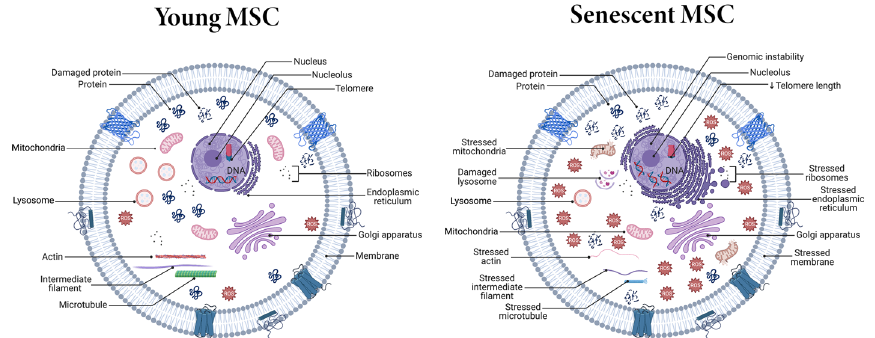
Fig. 5 Concept of young MSCs versus senescent MSCs, showing the major cellular and organellar differences between normal and senescent MSCs. Senescent MSCs contain more damaged DNA and proteins, stressed organelles, short telomeres, and induced